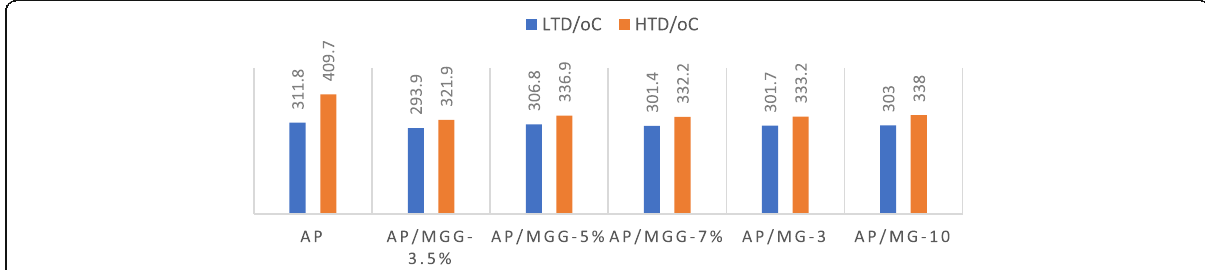
Fig. 13 Thermodynamic parameters of different proportions of